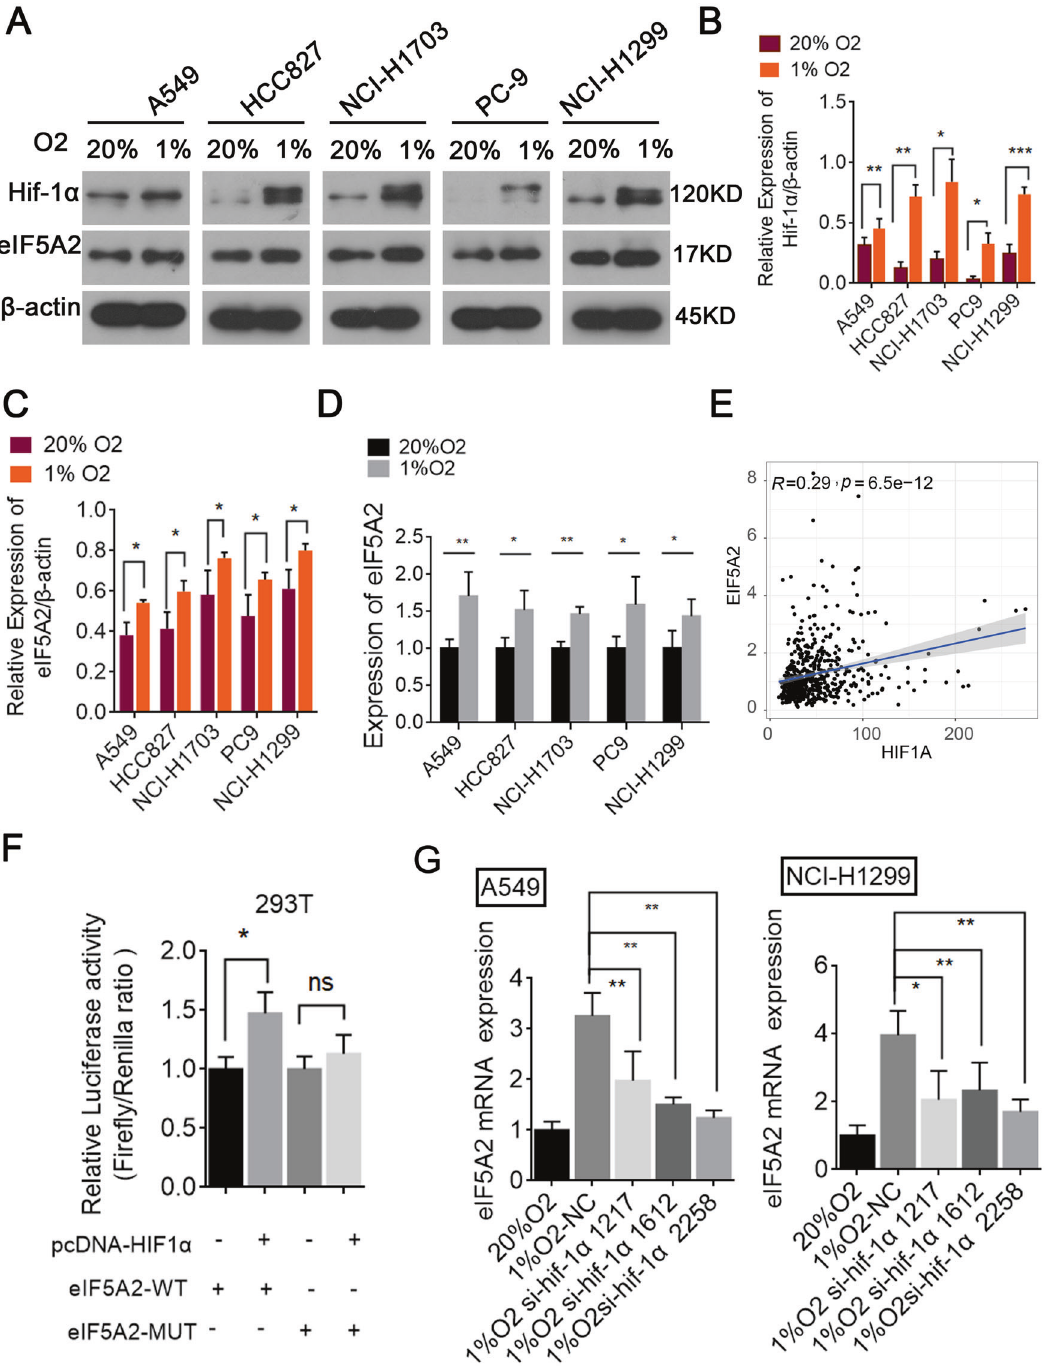
Fig. 2 Expression of HIF-1 α and eIF5A2 were upregulated under hypoxic conditions. A – D Western blotting ( A – C ) and qRT-PCR ( D ) results showing that the expression levels of HIF-1 α and eIF5A2 in fi ve NSCLC cell lines (A549, HCC827, NCI-H1703, PC9, and NCI-H1299) increased under hypoxic conditions. E A scatter plot suggesting that eIF5A2 levels correlated signi fi cantly and positively with ATG3 levels ( R = 0.36, p < 0.001). F Luciferase activity analyzed after HEK293T cells were co-transfected with the indicated luciferase reporter plasmids, vector, or pcDNA eIF5A2. G qRT-PCR results suggesting that eIF5A2 expression in A549 and NCI-H1299 cells decreased after HIF-1 α silencing. * P < 0.05, ** P < 0.01. eIF5A2 monoclonal antibody. The results showed high levels of in tissues of patients with NSCLC (Fig. 3D, E). Interestingly, survival eIF5A2 in NSCLC tissues and a cytoplasmic location, similar to that analysis indicated that patients with NSCLC and low eIF5A2 predicted using the uniprot database [20] (Fig. 3G). Abnormally expression tend to have better survival outcomes (Fig. 3F). high eIF5A2 expression in NSCLC suggests its potential as a Immunohistochemistry (IHC) was used to explore eIF5A2 levels therapeutic target to treat NSCLC. in tumor and normal tissues of two patients with NSCLC using an